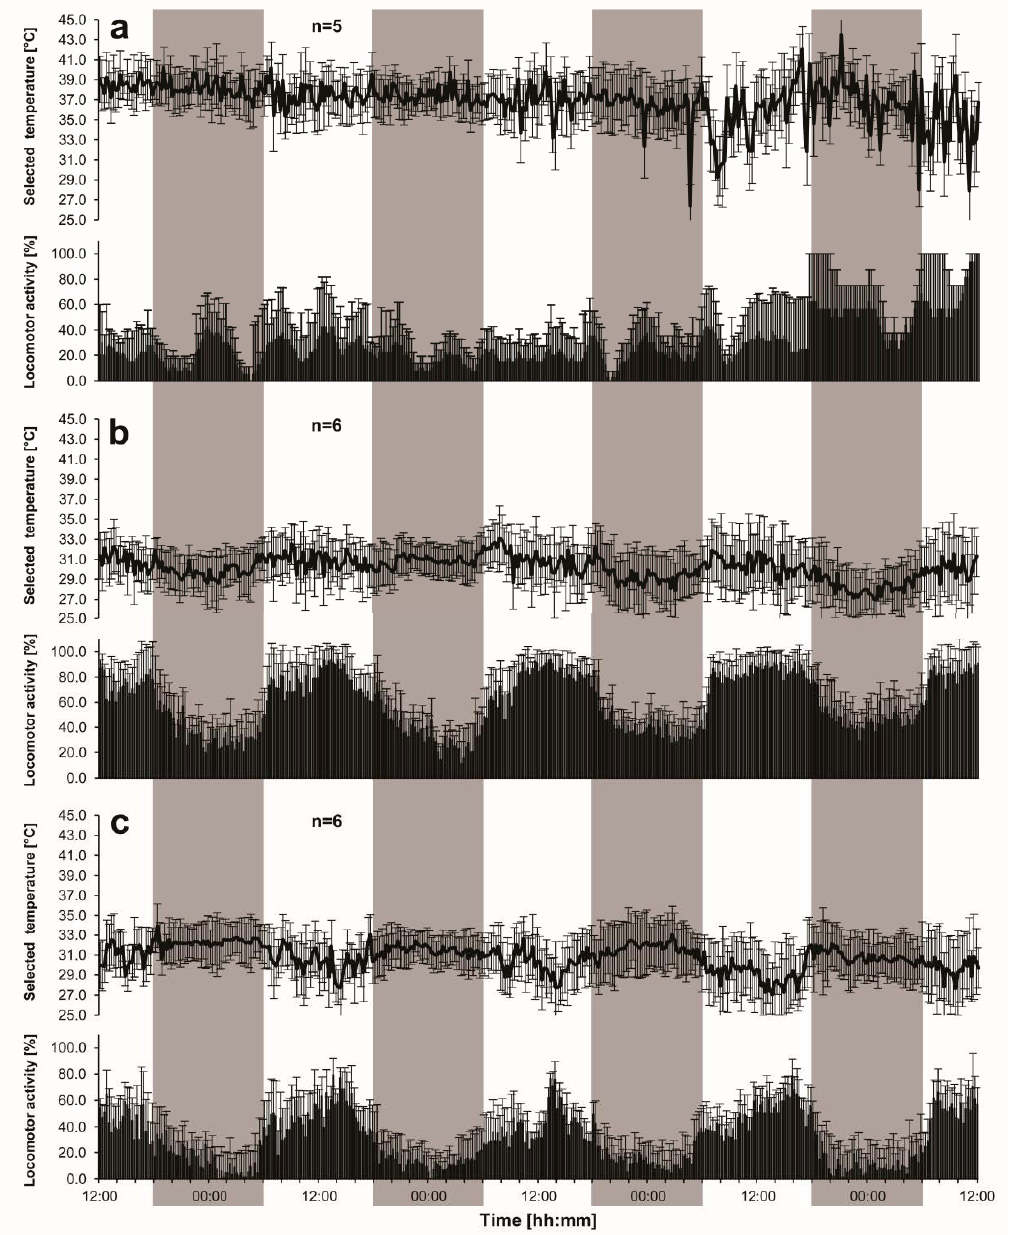
Figure 1. Daily changes in mean ( ± SD) values of thermal preference and locomotor activity of single queens ( a ) and queenless ( b ) as well as queenright ( c ) groups of worker honeybees. In both queenless and queenright groups, smoothed courses of the 15-min averages would have occurred at every daytime period (at 13:52 ± 01:55, 11:43 ± 01:20, and 14:31 ± 01:41, during the final three days, respectively), while nadirs were always recorded at night (at 00:50 ± 01:46, 02:34 ± 02:40, and 02:09 ± 01:20, respectively). In queenright groups (Figure 1c), the circadian rhythm (15-min averages) minimum values occurred at daytime (at 16:50 ± 01:20, 12:33 ± 01:20, and 17:31 ± 01:41, respectively), and the maximum values were recorded at night (at 20:40 ± 01:46, 21:43 ± 02:11, and 21:31 ± 01:13,